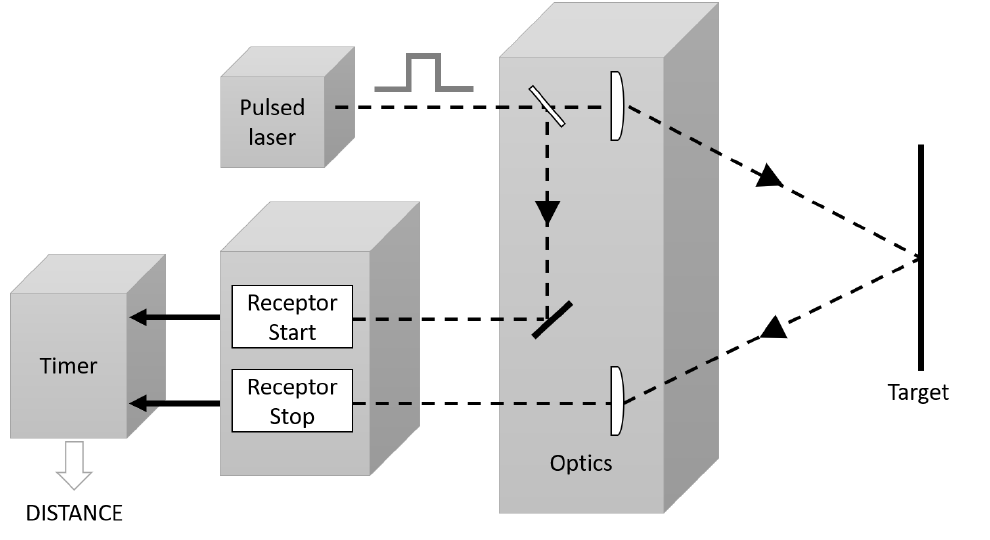
Figure 1. Pulsed time-of-flight (TOF) measurement